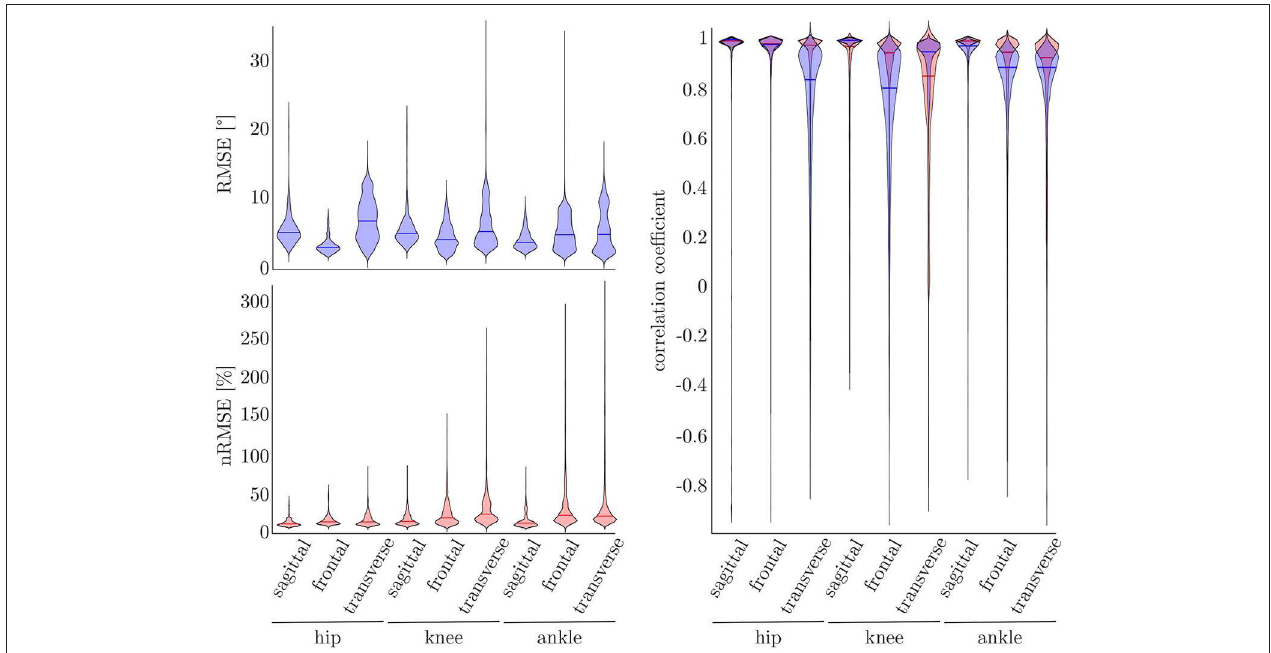
FIGURE 7 | On the right, the distribution of the correlation coefficient for the kinematic (blue) and kinetic (red) model is displayed. Additionally, on top, the distribution of the RMSE for the kinematic and on the bottom the distribution of the nRMSE for the kinetic model can be found. The violin’s width displays how much data is accumulated, while the height shows the range of the distribution. The horizontal line indicates the median value of the distribution.